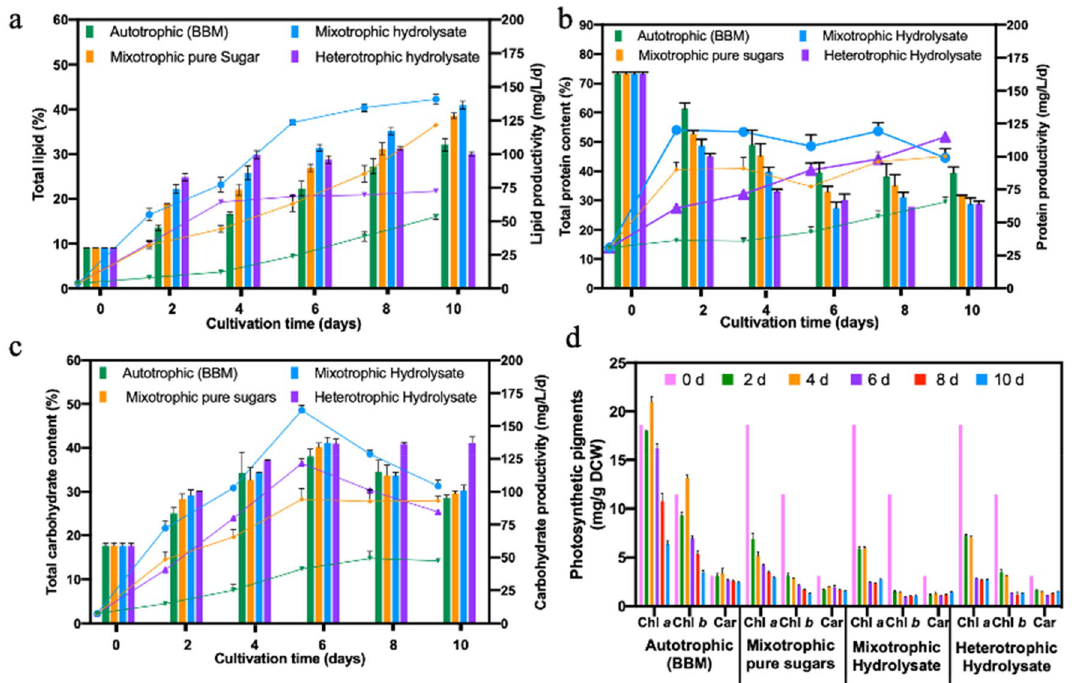
Figure 5. Changes in (a) total lipid content and productivity; (b) total carbohydrate content and productivity; (c) total protein content and productivity; and (d) photosynthetic pigment content of Chlorella 395 cultivated in various growth media and trophic modes. Lines represent productivity, whereas bars represent cellular content